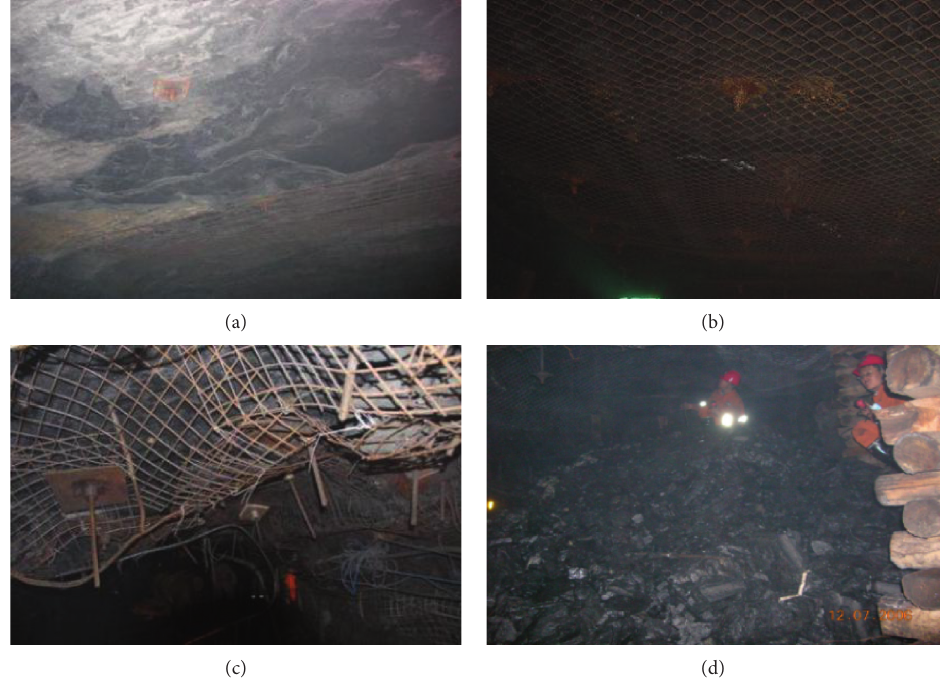
Figure 1: Site map of different stable types of coal roadway roof. (a) Stable. (b) Medium stable. (c) Falling. (d) Easy to